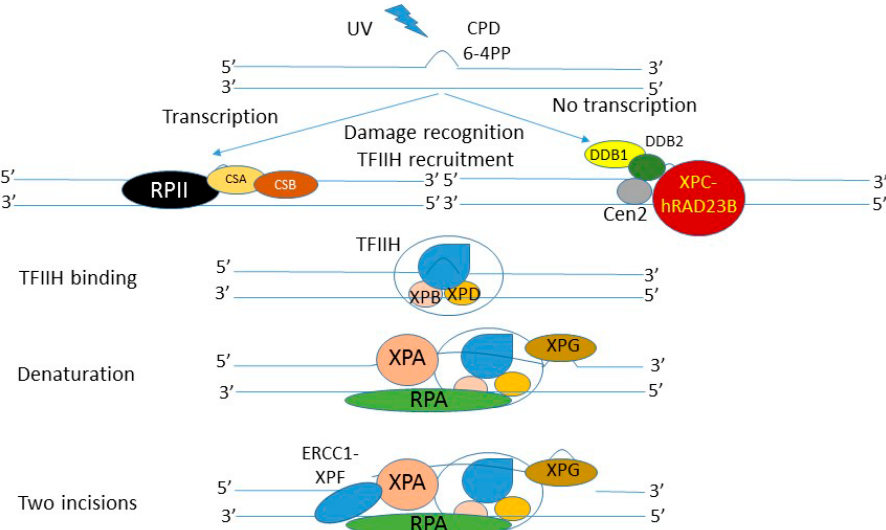
Figure 4. Simplified scheme of nucleotide excision repair of cyclobutane pyrimidine dimer (CPD) and pyrimidine-pyrimidone (6-4) photoproduct (6-4PP) induced by UV radiation. Several other